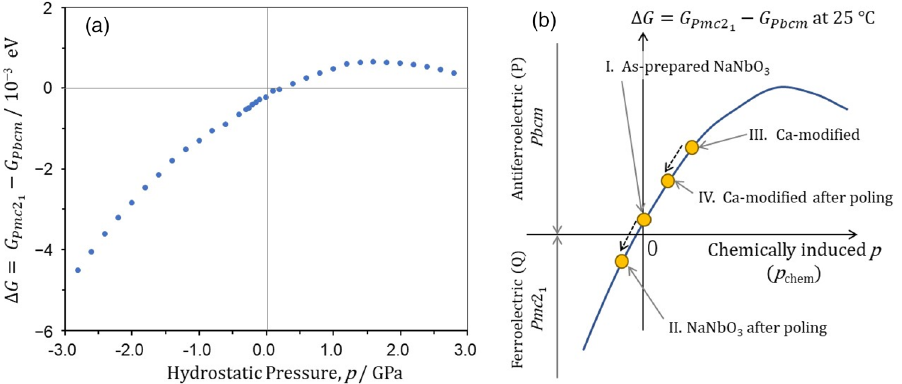
G Pbcm ), where G Pmc 2 G Pmc 2 G Pbcm denotes the free energies of Figure 8. Free energy difference ( (cid:31) G 1 − 1 and = the FE-Q phase ( Pmc 2 1 ) and the AFE-P phase ( Pbcm ) one: ( a ) obtained by DFT calculations for NaNbO 3 at zero kelvin and ( b ) aligned for the ceramic samples at 25 ℃ . The AFE-P phase is stabilized in the region of ∆ G > 0 while the FE-Q phase appears in the region of ∆ G < 0. In reality, the Ca ions and the vacancies on the A site play a different role, while the FE and AFE orderings stem primarily from an orbital interaction between Nb-4 d and O-2 p . We assume that the effects of the Ca modification on (cid:31) G for our samples is simplified by the change in chemically induced p ( p chem ) in ( b